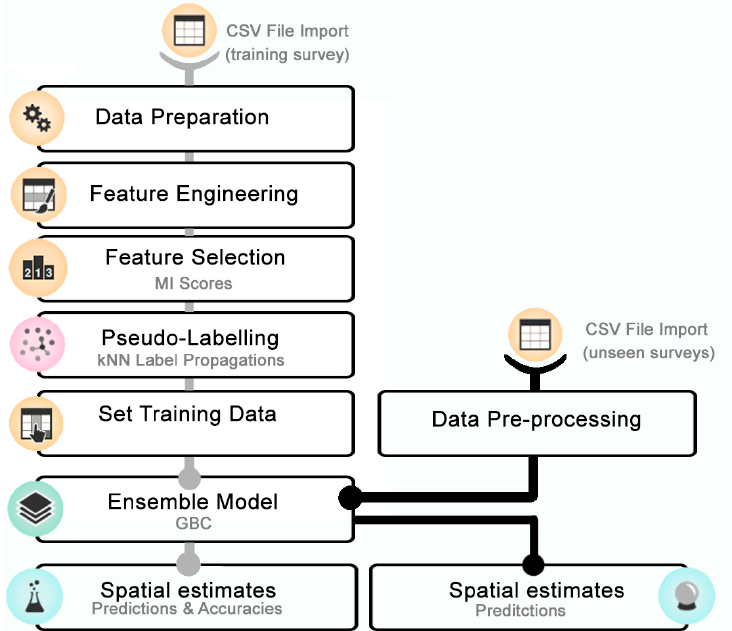
Figure 8. ML data-processing workflow to train the model before performing predictions on un- seen data.